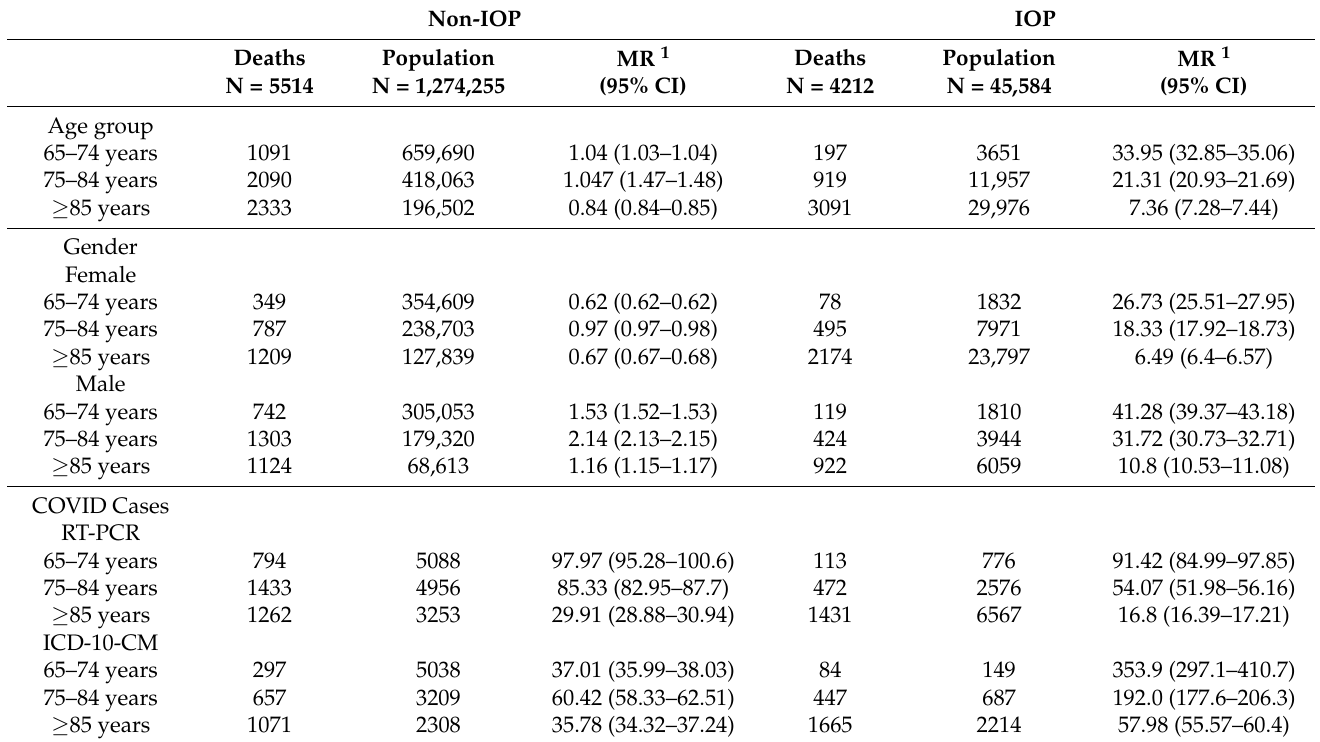
Table 4. Cumulative weekly mortality rate by age group or gender of COVID-19